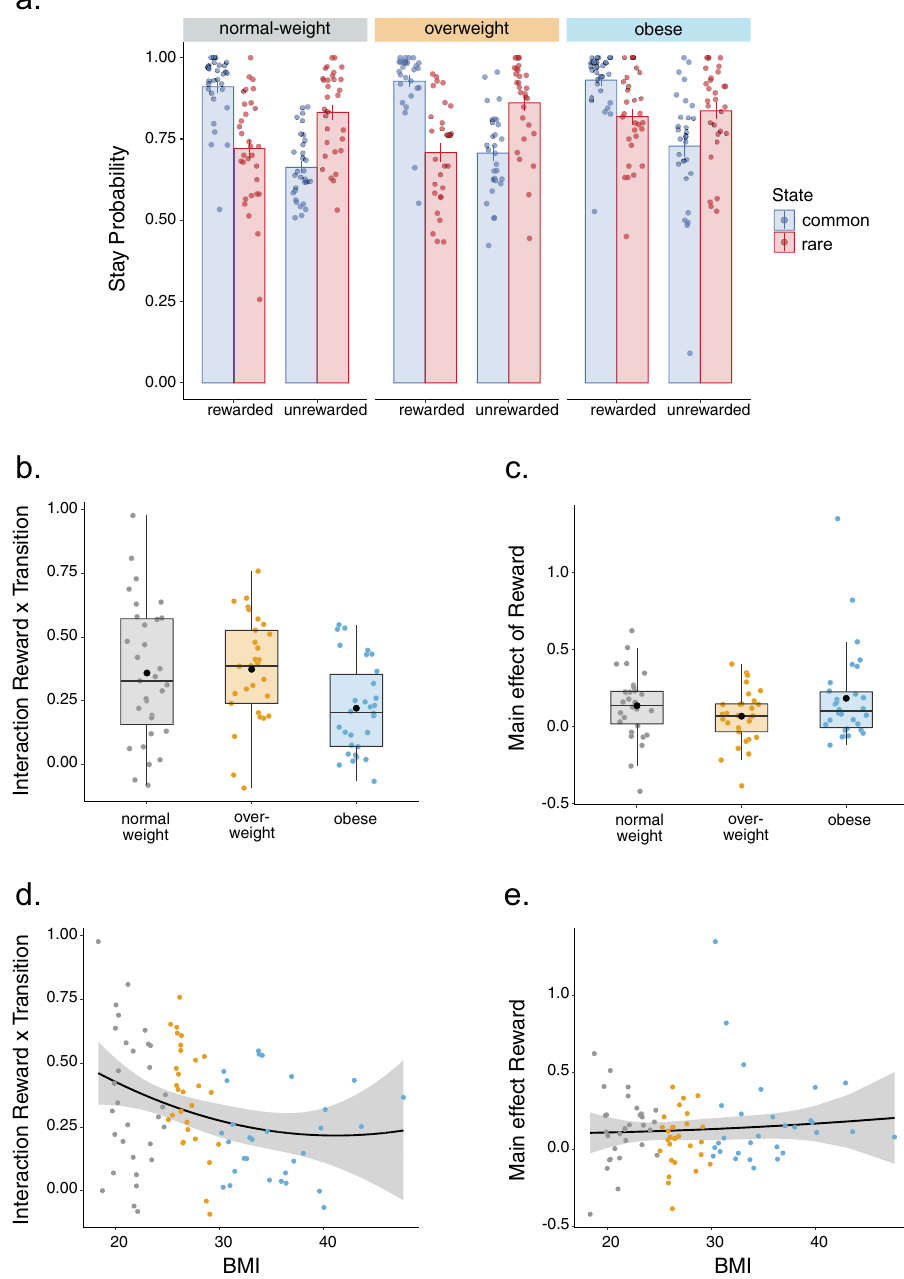
Figure 2. Stay probabilities. ( a ) Average stay probabilities per condition for each group. Error bars represent ± 1 SEM. ( b ) On the group level, the use of a model-based choice strategy (i.e., the Reward × Transition interaction term) was lower for obese relative to normal-weight and overweight participants, whereas ( c ) the use of a model-free choice strategy (i.e., the main effect of Reward) did not differ significantly between groups. The box plots in ( b ) and ( c ) show the median and interquartile range for each group, with the black dot denoting the mean. ( d ) On the continuous level, the Reward × Transition interaction term was negatively related to BMI, with no additional significant quadratic relationship. ( e ) No linear or quadratic relationship was observed between BMI and the main effect of Reward. The scatter plots in ( d ) and ( e ) show the model fit (black line) and confidence interval (shaded) of the respective regression models with predictors BMI and BMI 2 . Individual data points are color-coded based on weight group for illustrative